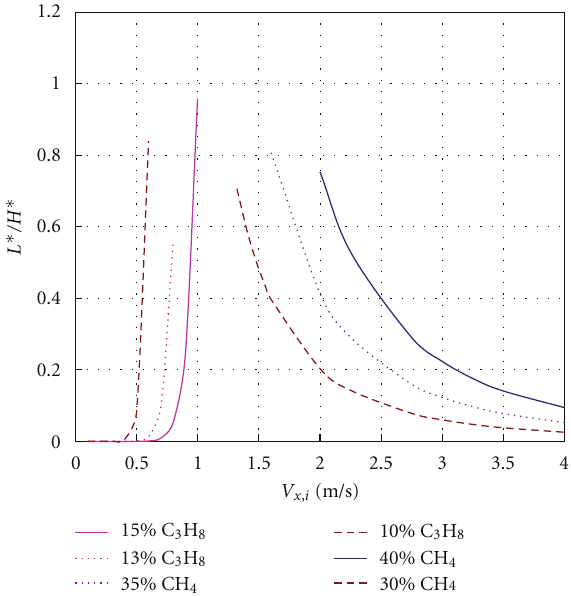
Figure 6: Theoretical predictions for L ∗ /H ∗ ratio as given by (6). The group of lines on the left correspond to diluted C 3 H 8 mixtures ( Sc ≈ 1 . 3 and N 2 percentages of 85%, 87%, and 90%) and those on the right correspond to diluted CH 4 mixtures ( Sc ≈ 0 . 74 and N 2 percentages of 60%, 65%, and